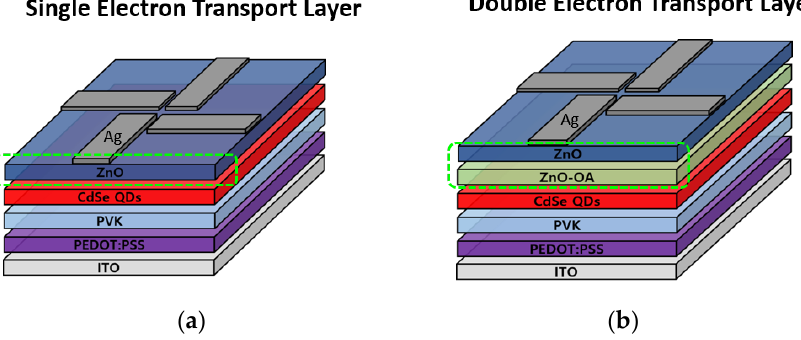
Figure 1. This Schematic cross-sectional view of ( a ) ITO/PEDOT:PSS/PVK//CdSe/ZnS//ZnO/Ag (single ETL) and ( b ) ITO/PEDOT:PSS/PVK//CdSe/ZnS//ZnO-OA/ZnO/Ag (double ETLs) QLEDs.